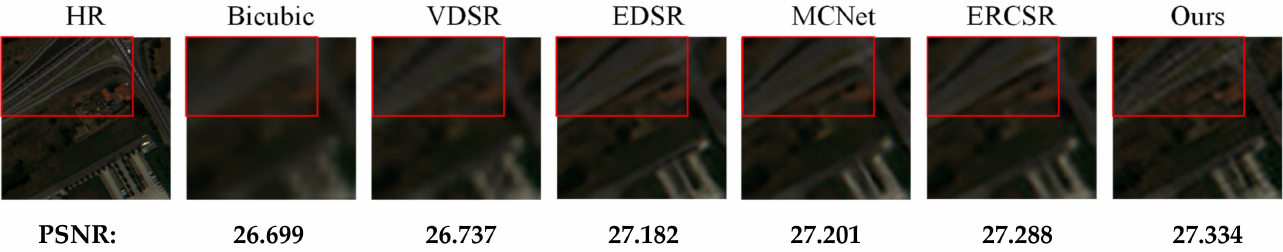
Figure 10. The reconstructed images of test images in the Pavia University dataset using various algorithms. Reconstructed images with spectral bands 60-35-13 as R-G-B channel with a scale factor of 8. The more obvious parts are framed by red boxes, and we can see that the best way to reconstruct the edge of the highway is our method.